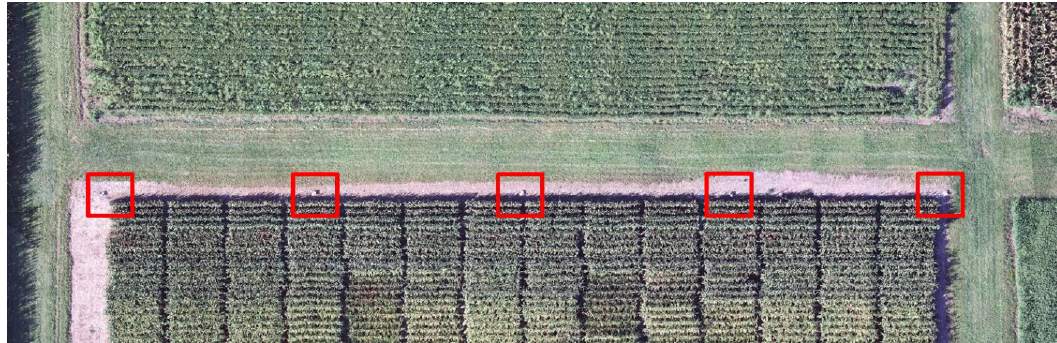
Figure 24. Orthophoto result from Direct Approach for FLIR RGB September 14th data collection (red boxes show the location of the check points, Original GSD ≈ 0.01 m